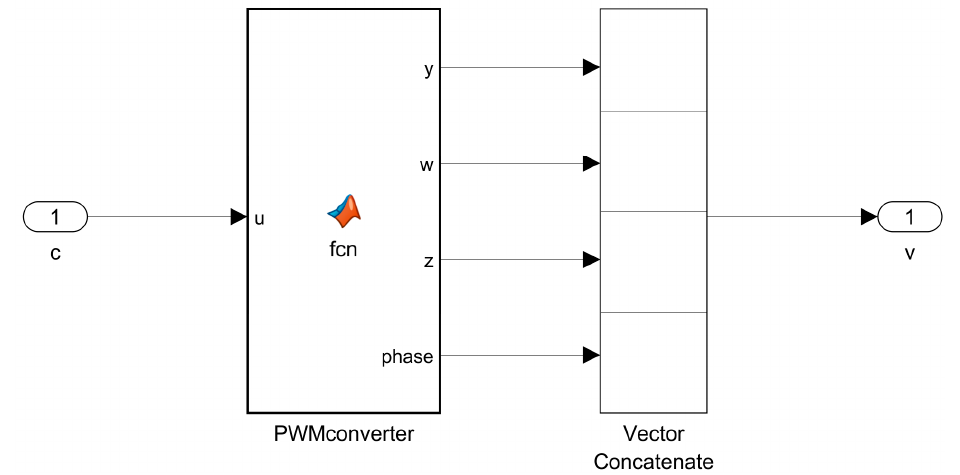
Figure 4. The PWM converter subsystem in the Simulink model.